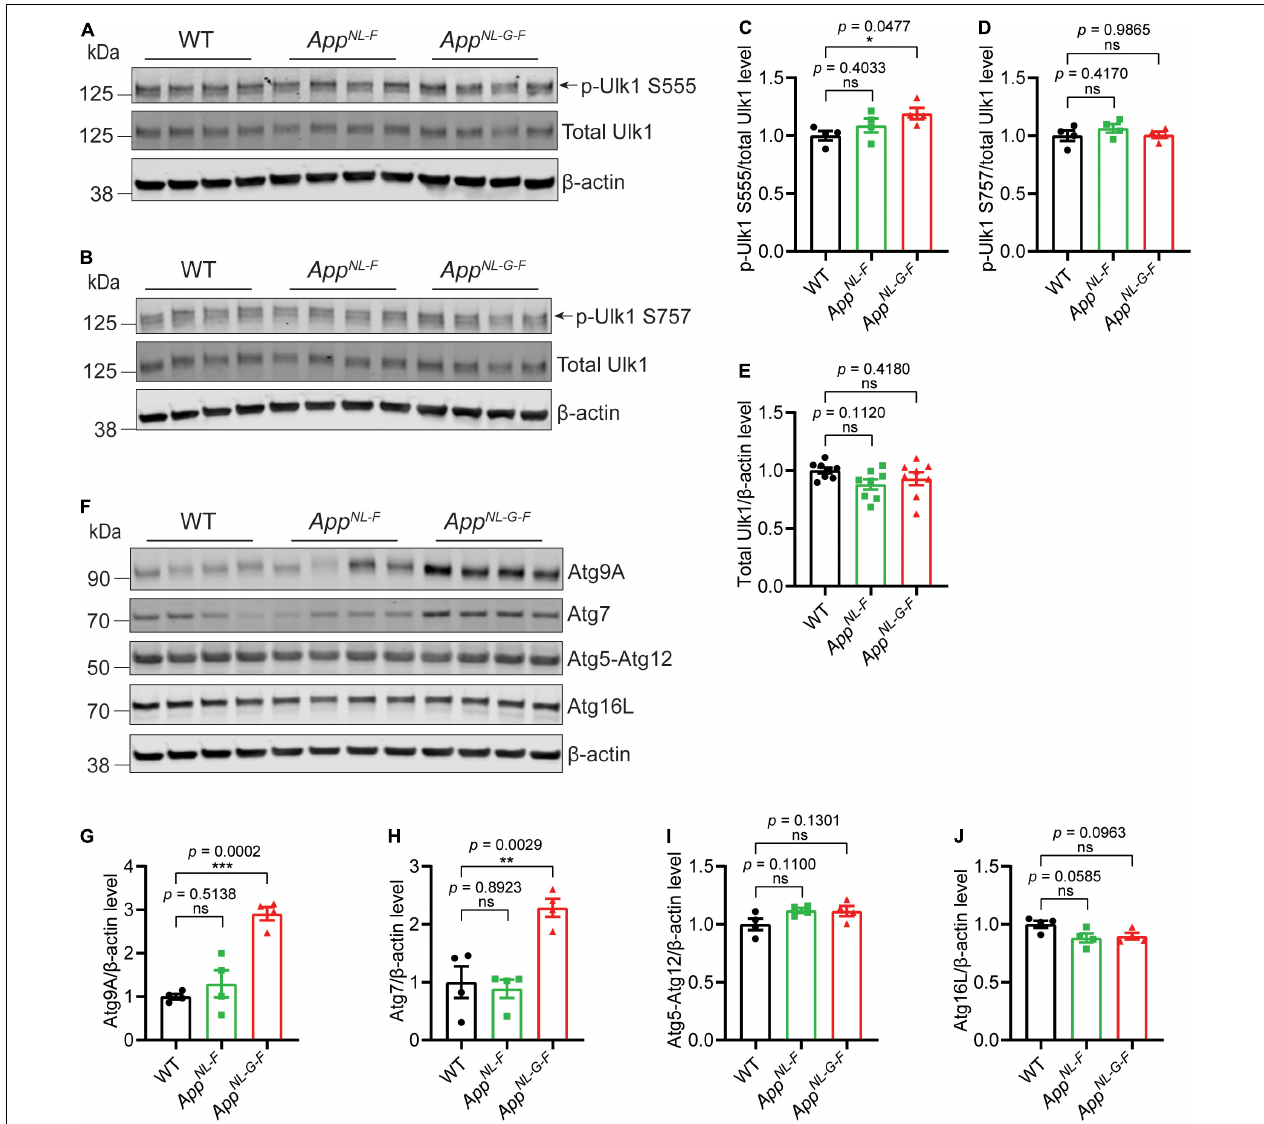
FIGURE 3 | Increased levels of key autophagy proteins in App NL − G − F mice. Western blot analysis of cytosolic fraction of cortical brain homogenates from 12-month-old App NL − F and App NL − G − F mice were analyzed for Ulk1, p-Ulk1 S555 and p-Ulk1 S757 (A–E) , Atg9A, Atg7, Atg5-Atg12, Atg16L (F–J) , and the levels were quantified by densitometry ( n = 4, * p < 0.05, ** p < 0.01, *** p < 0.001). Data are represented as mean ± SEM. Ns, not